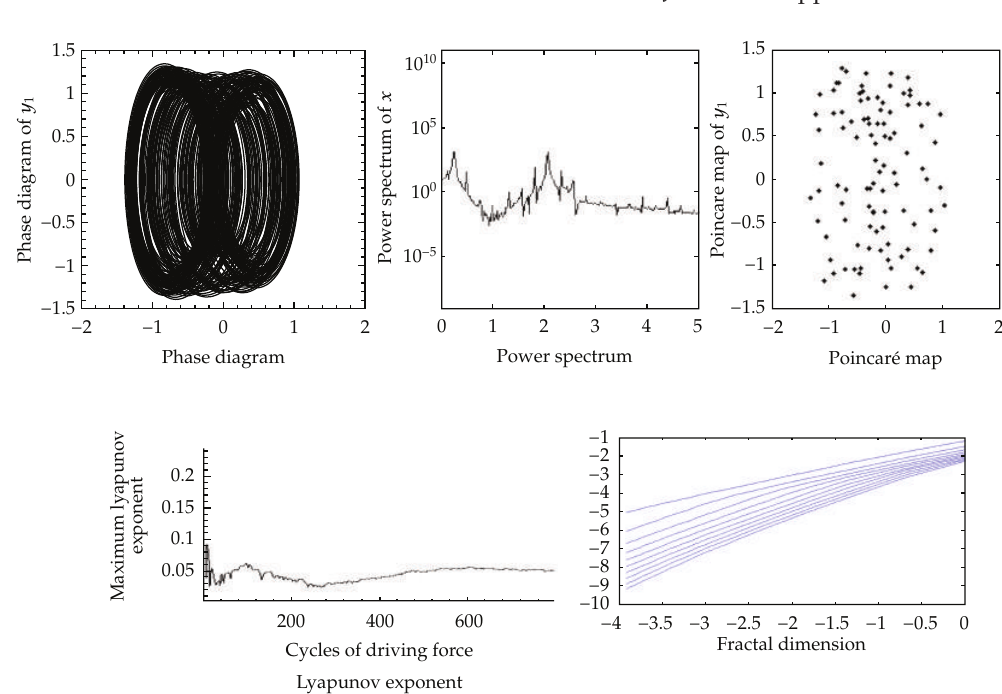
Figure 9: Simulation results obtained for gear-bearing system with s (cid:9) 4 . 2 for y 1 (cid:6) l ∗ (cid:9) 0 . 3 (cid:7)